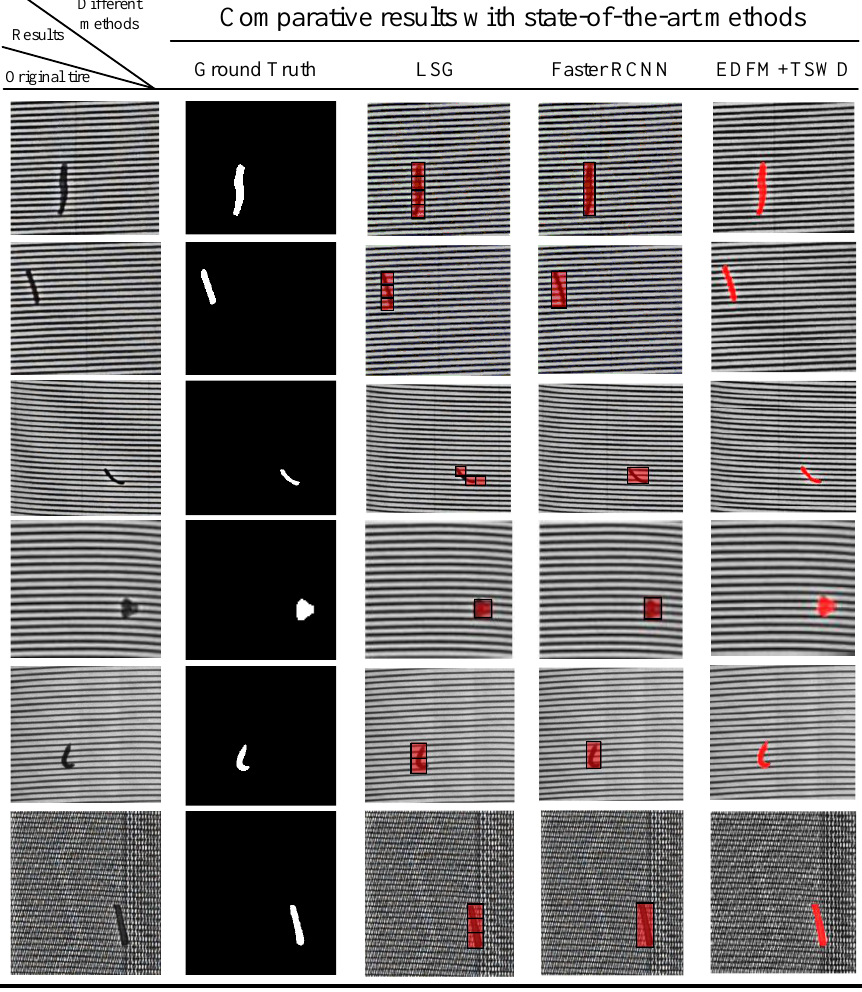
Figure 13. Comparative experiments with state-of-the-art